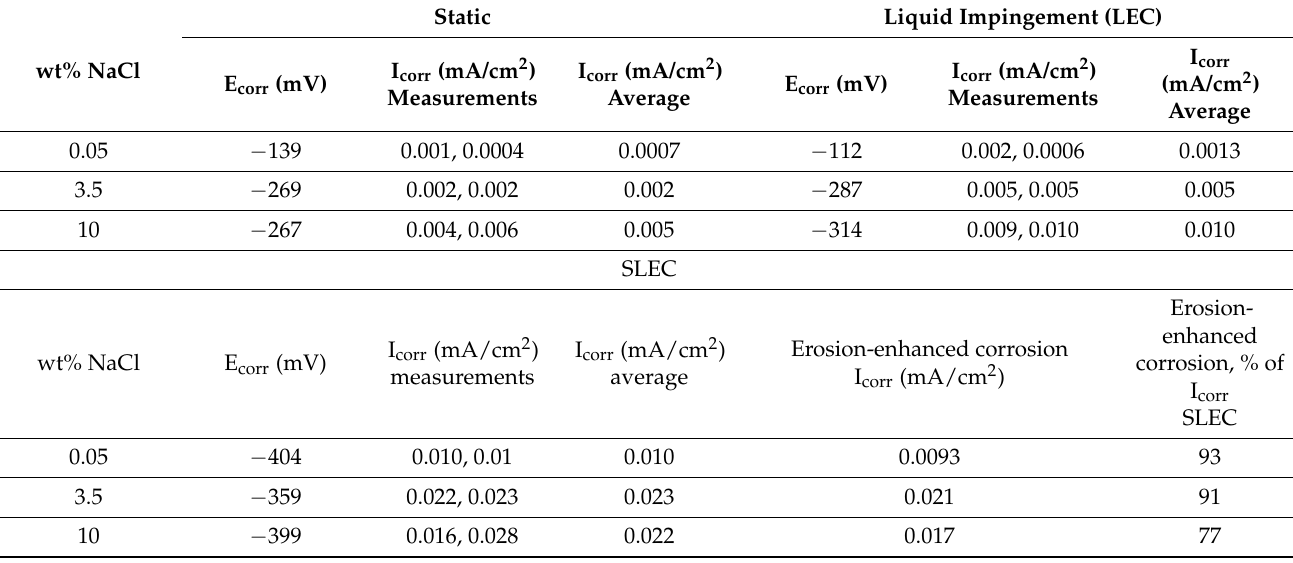
Figure 7. Polarisation plots for UNS S31600 in impinging solution containing sand particles (SLEC). Table 4. Corrosion rates of UNS S15500 in the different hydrodynamic